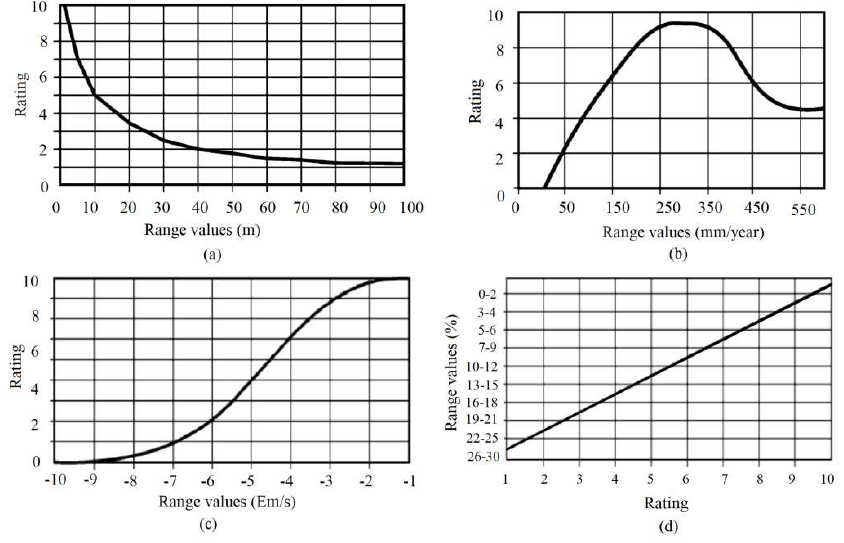
Figure 2. Ratings in SINTACS for ( a ) S, ( b ) I, ( c ) C, ( d ) S parameters (adapted from [29]).